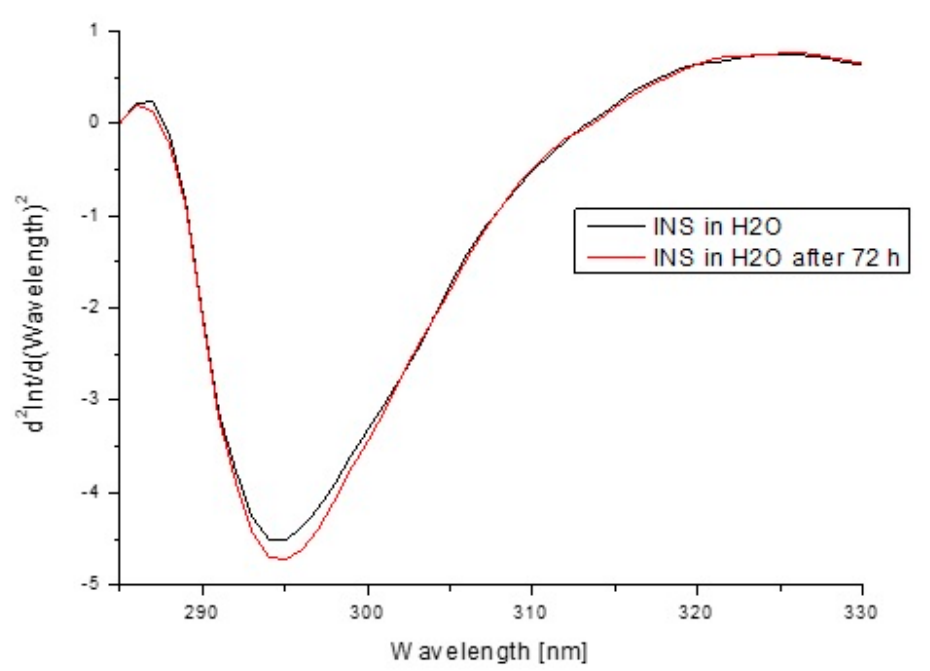
Figure 14. Second derivative emission fluorescence spectra of insulin at 1.04 × 10 − 5 g/cm 3 concentration in H 2 O immediately after sample preparation and after 72 h.